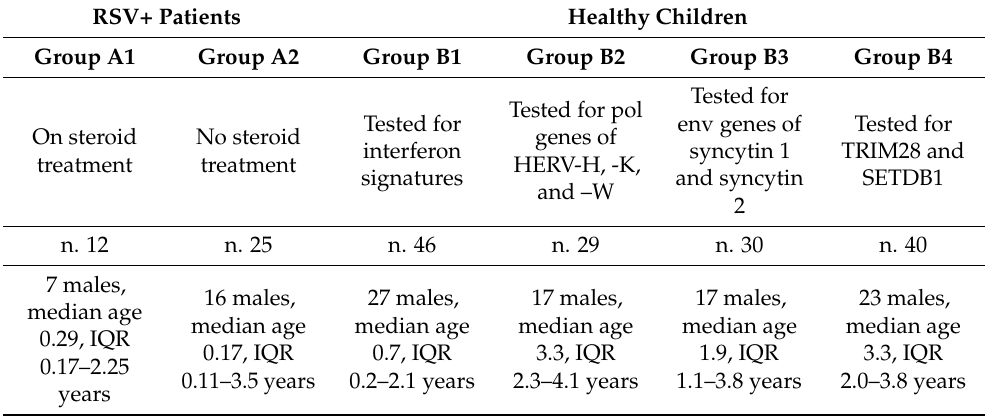
Table 3. Characteristics of subgroups of RSV+ patients and healthy children. IQR: interquartile range, expressed as 25 and 75 quartile